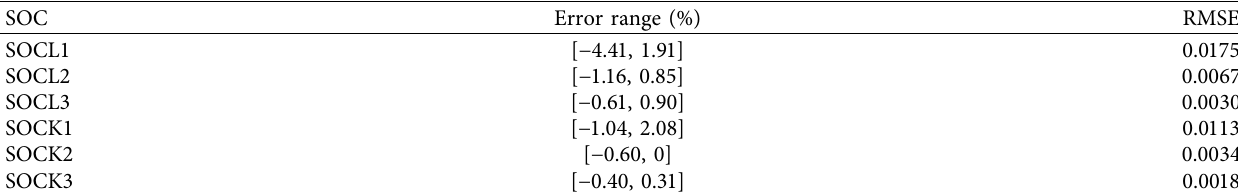
Figure 11: The SOC estimation results and errors of nRC models identified by the KF method. Table 3: The error and RMSE of SOCL and